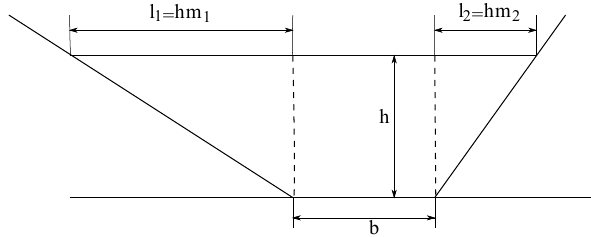
Figure 2. Trapezoidal cross section of a channel with definitions of symbols used in the text.